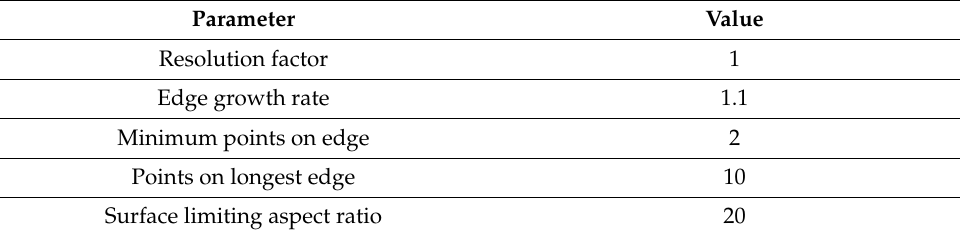
Table 5. CFD mesh